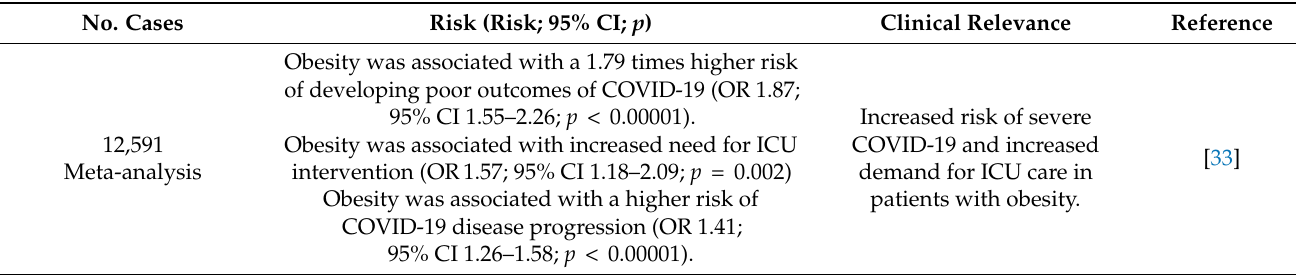
Table 2. Risk of severity and mortality in obese patients with